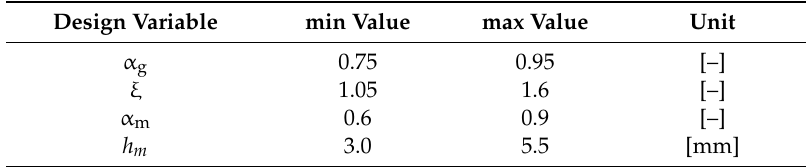
Table 2. The ranges of design variables during optimization process.